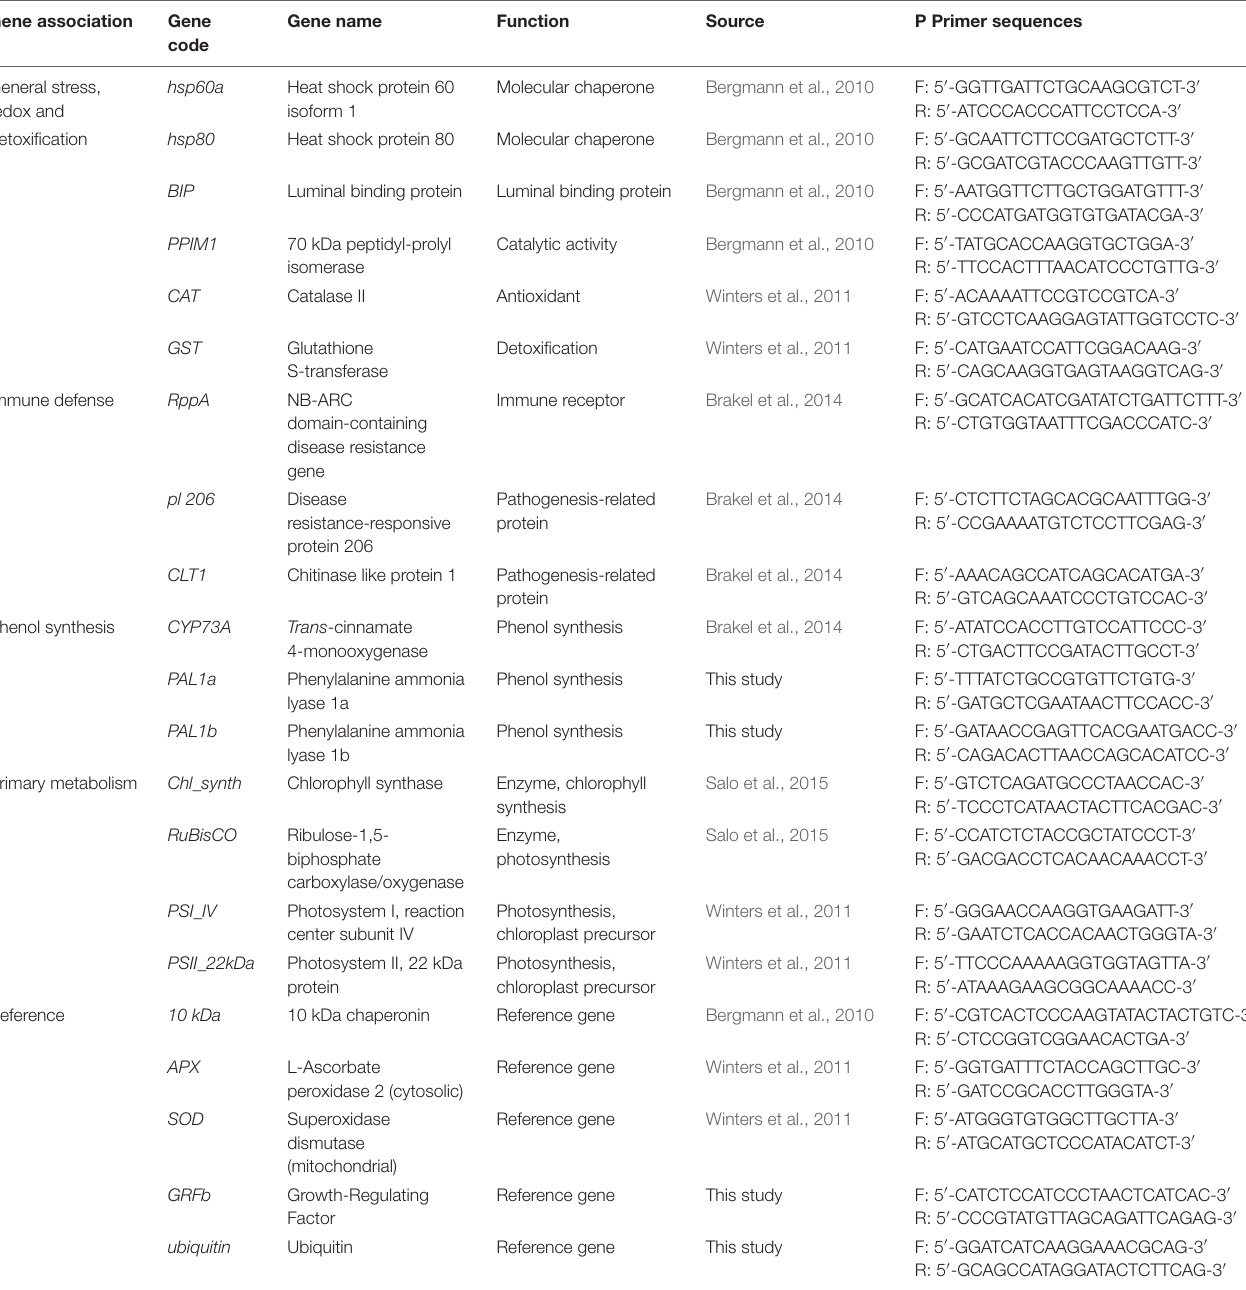
TABLE 1 | Information on target